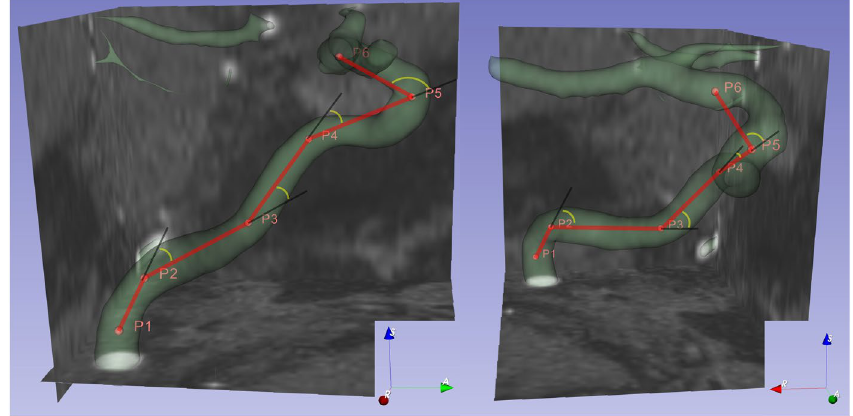
Figure 1. The three-dimensional reconstruction image shows each measurement under the RAS system. The image on the left shows the anatomical coordinates by right-to-left projection, while the image on the right shows the same situation by anterior-to-posterior projection. Pink points represent fiduciary points: P1, the beginning of the vertical petrous ICA at the level of the carotid canal; P2, the inflection point between the vertical petrous ICA and the horizontal petrous ICA; P3, the inflection point between the horizontal petrous ICA and the vertical cavernous ICA; P4, the inflection point between the vertical cavernous ICA and the horizontal cavernous ICA; P5, the anteriormost point of the carotid siphon; P6, the point of emergence of the anterior choroidal artery. Thick red lines are correlated with the vectors between two adjacent points. Yellow arcs represent the change in the flow